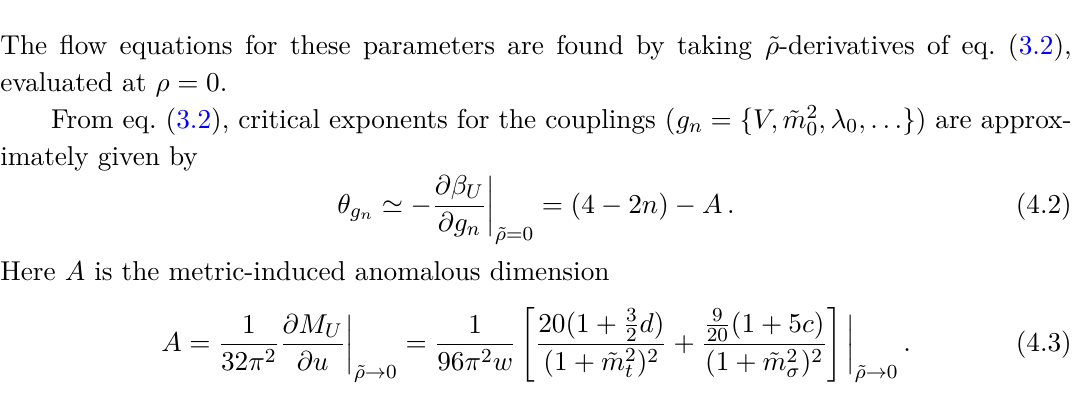
Table 2 . Critical exponents at the AS-fixed point for various matter contents. The rows are the same as for table